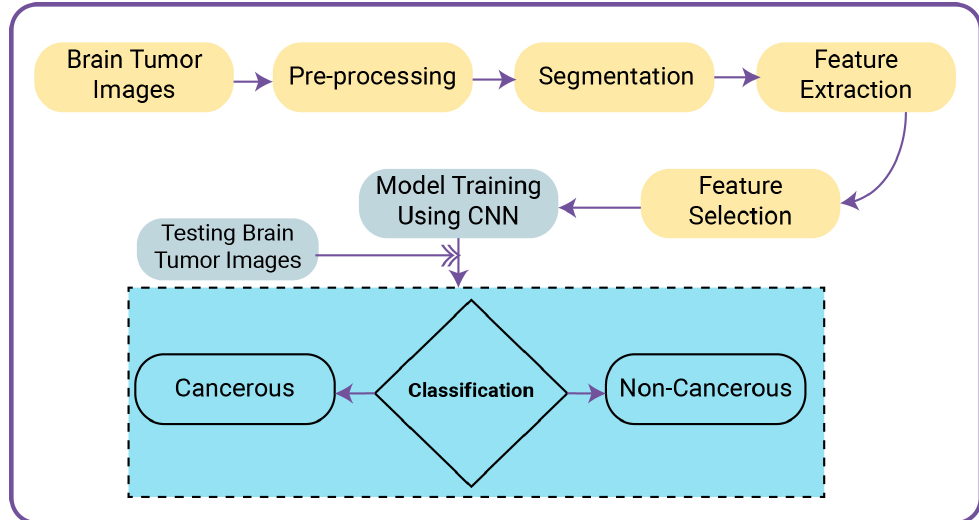
Figure 8. Proposed model for